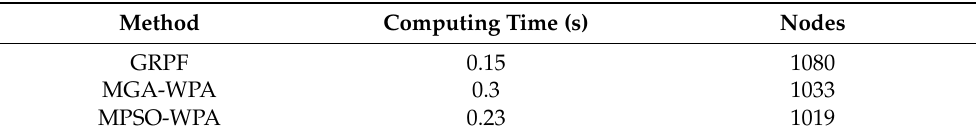
Figure 5. Distribution of nodes with Delaunay’s triangulation in the final iteration for ( a ) the GRPF, ( b ) MGA-WPA, and ( c ) MPSO-WPA methods. The stability tests of integer-order digital filter are executed in the transformed region | w | < 1. Phase quadrants of mesh nodes on the w -plane: •Q = 1, •Q = 2, •Q = 3, and •Q = 4. Table 1. Computing times and numbers of generated nodes in the stability tests of a considered integer-order digital